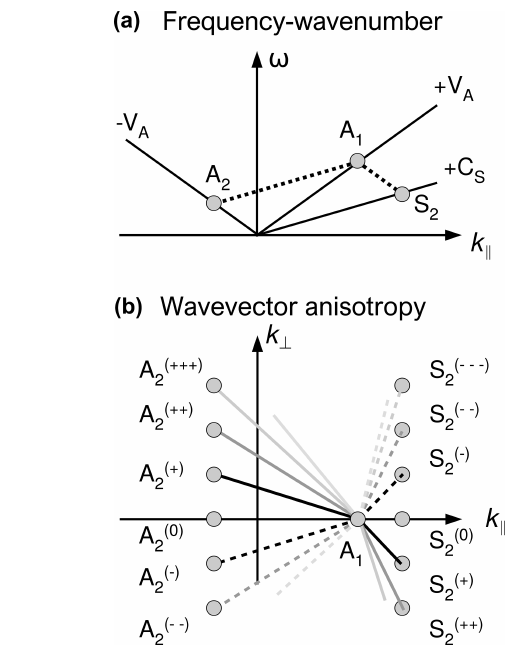
Figure 1. Three-wave couplings of the decay instability (parallelo- gram formation) in the frequency–wavenumber domain parallel to the mean magnetic field (a) and in the wave–vector domain span- ning parallel and perpendicular directions (b)